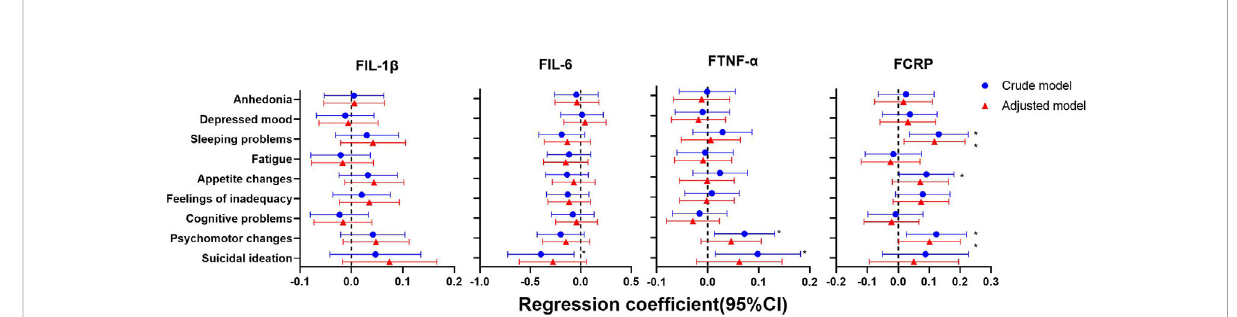
FIGURE 5 Generalized linear models of the associations between symptom-speci fi city of depressive symptoms at baseline and in fl ammatory biomarkers at follow-up (n=248). IL-1 b , interleukin-1 b ; IL-6, interleukin-6; TNF- a , tumor necrosis factor- a ; CRP, C reactive protein. a The blue plot represented the crude model which was not adjusted by any variables, and the red plot represented the adjusted model which was adjusted by residential area, self-reported family economy, self-rated health condition, father ’ s education level, mother ’ s education level, cigarette use and alcohol use. b F represented 2-year